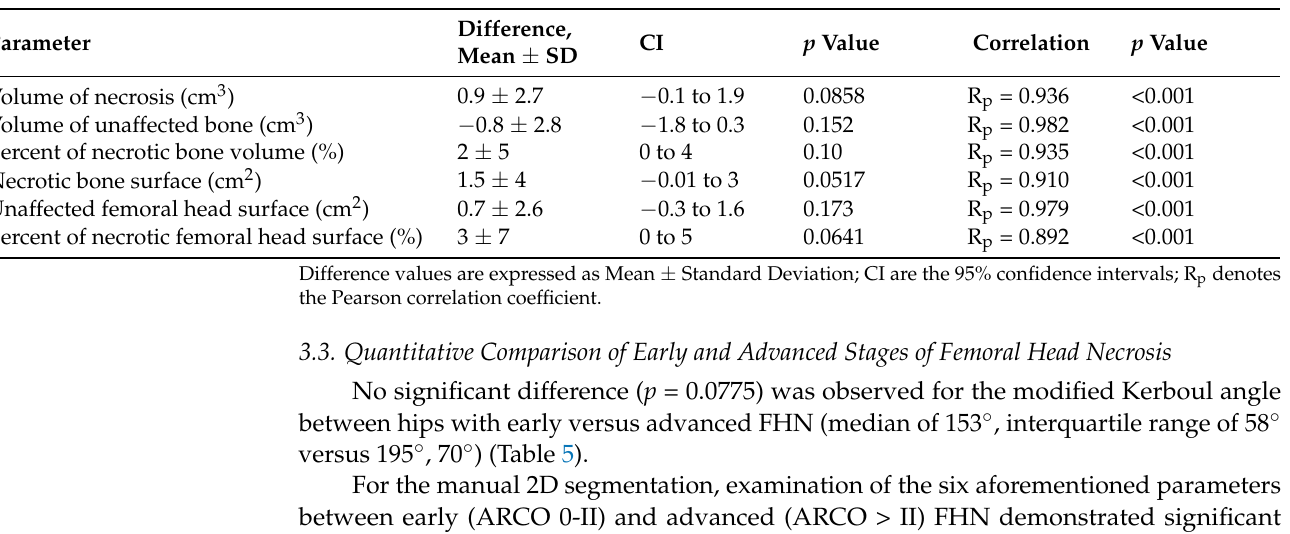
Table 4. Comparison of manual versus automatic segmentation of FHN based on 2D